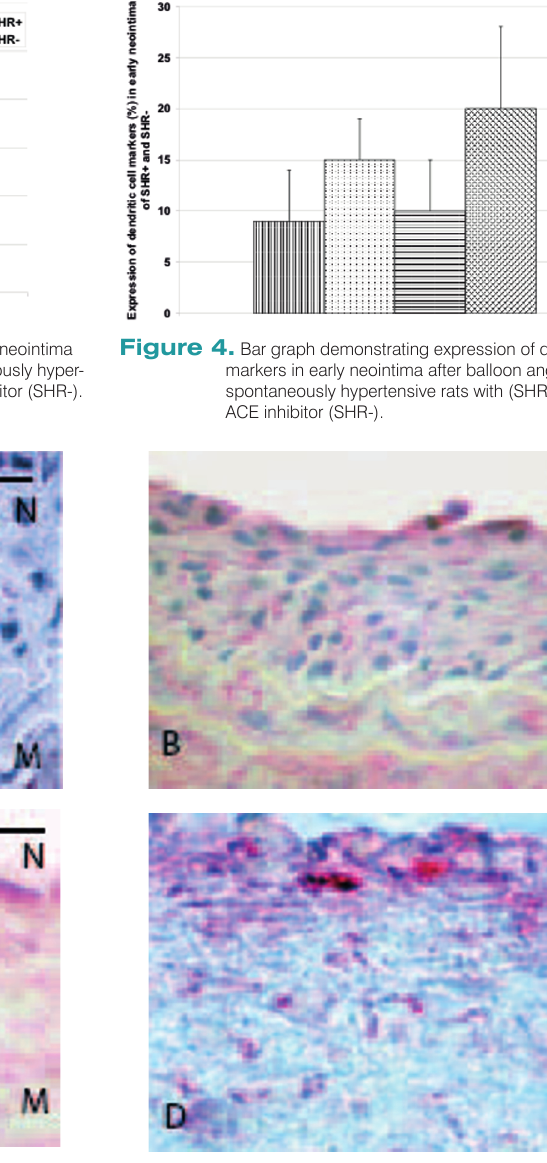
Figure 5. Photomicrographs of immunostaining for dendritic cells and AT1R+ cells in arterial wall at early time points after balloon angioplasty in spontaneously hypertensive rats with (SHR+) and without ACE inhibitor (SHR-) (A, B, C, D). (A) Positive labelling for OX-62+ dendritic cells in neointima. (B) Strong expression of AT1R in neointima and media. (C) Double immunostaining for S100 (red) and AT1R (dark blue) in neointima (no nuclear counterstaining). (D) Double immunostaining for HSP47 (red) and OX-62 (dark blue) in neointima (no nuclear counterstaining). N- neointima, M- media. For (A, B, C, D) graph bar= 20µm.